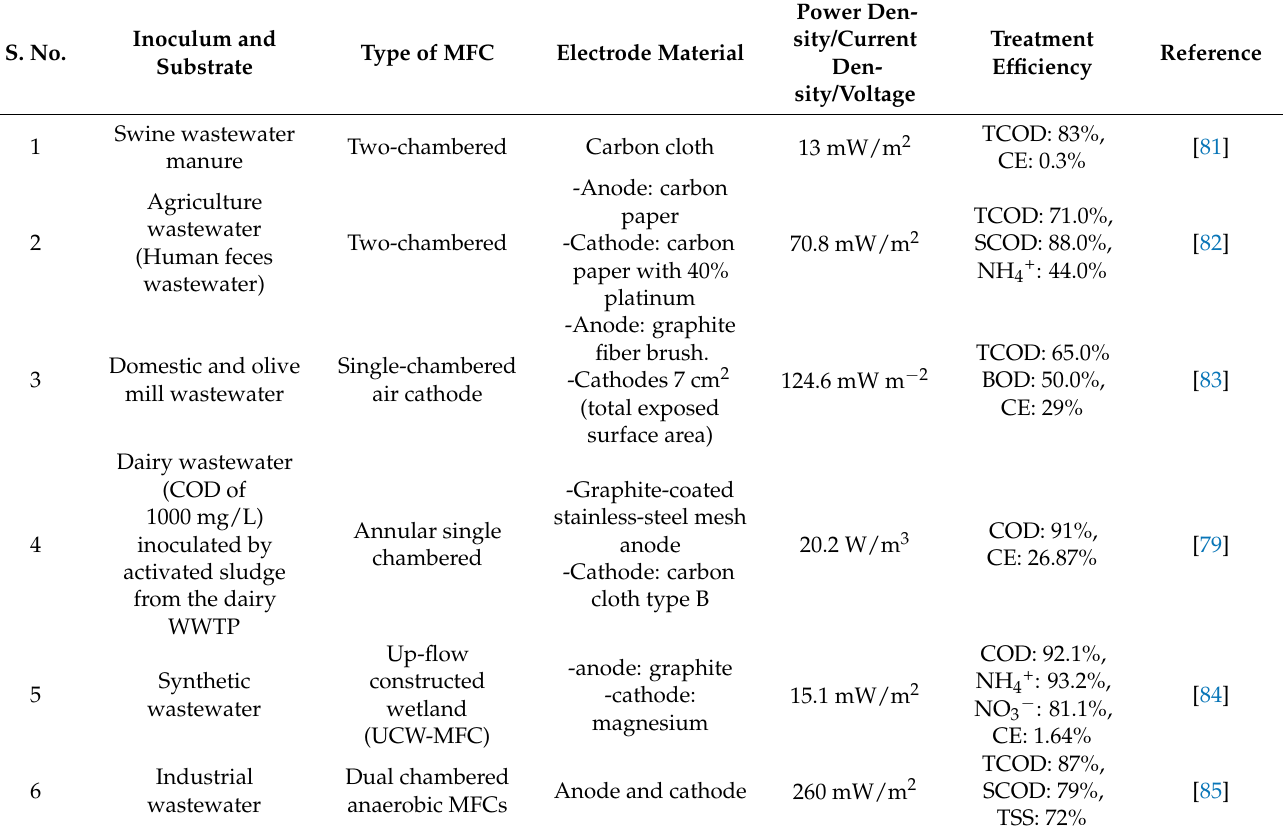
Table 1. Applications of MFCs in the treatment of different types of